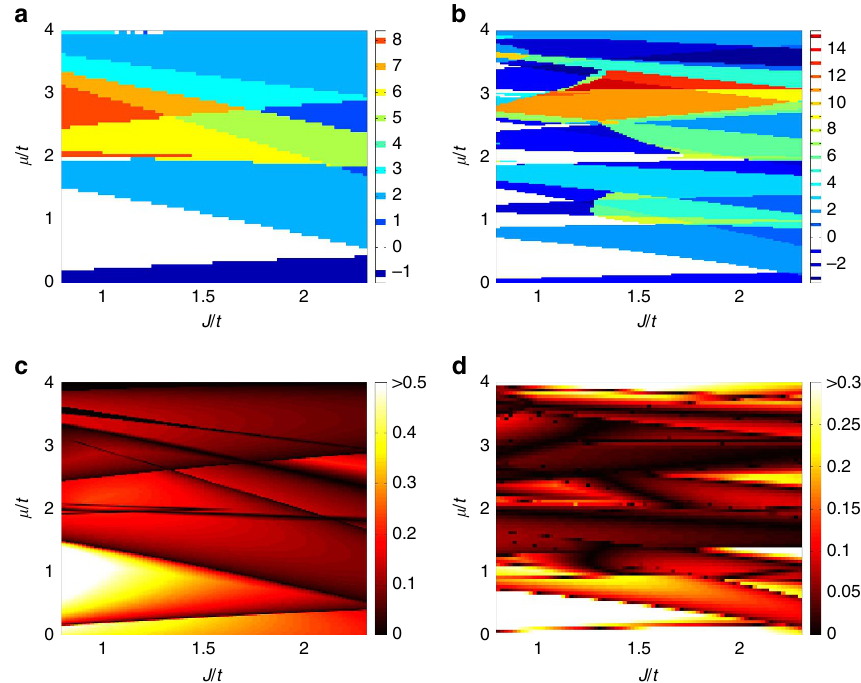
Figure 2 | Phase diagrams in the dense impurity limit. ( a , b ) Chern numbers, and ( c , d ) ratios of the induced superconducting gap to the host superconducting gap, as functions of the chemical potential m and the exchange field strength J , both in units of hopping strength t . ( a ) and ( c ), ( b ) and ( d ) correspond to the case of one magnetic adatom every 2 (cid:7) 2, or 3 (cid:7) 3 lattice sites, respectively. These phase diagrams are obtained by using the Hamiltonian in equation (1) with D ¼ 0.06 t and a ¼ 0.1 t ; m has been shifted such that m ¼ 0 implies the chemical potential lying in the center between the two spin-split band